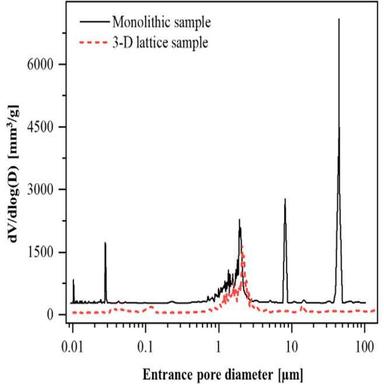
Entrance pore size distribution obtained by MIP for monolithic and 3Dlattice samples.